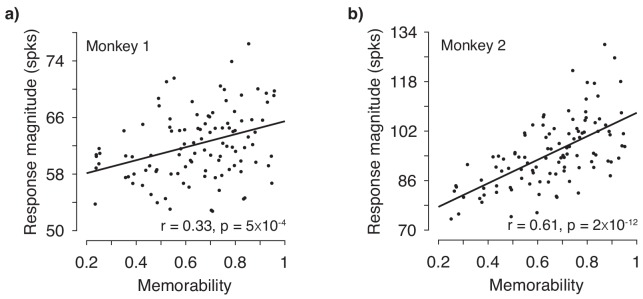
The correlation of memorability and population response magnitude, for each monkey individually.(a-b) Figure 2b replotted for each monkey individually (monkey 1: 353 units; monkey 2 354 units). To compensate for parsing the data, the spike count window was increased to 250 ms in these plots (positioned 150 ms – 400 ms) relative to the 80 ms window depicted in Figure 2. The Pearson correlation and its p-value are labeled. The following two points were included in computing the correlations but fall outside the boundaries of the plot or are obscured by text: Monkey 1 (panel a): memorability = 0.86, response magnitude = 83.6; Monkey 2 (panel b): memorability = 0.57, response magnitude = 71.5. Solid lines depict the linear regression fits to the data.